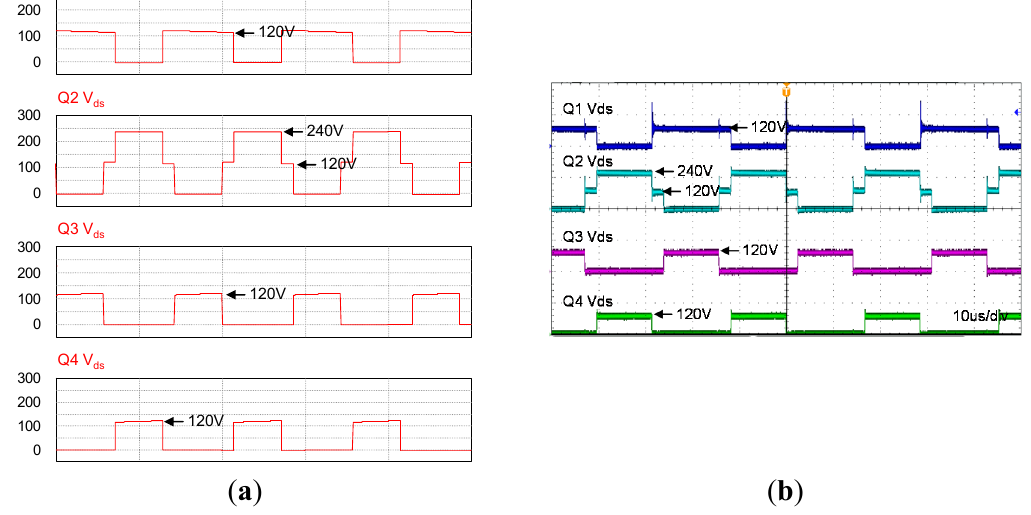
Figure 21. Waveforms of open-circuit voltage of switches Q 1 ~ Q 4 in the discharge mode at full load ( a ) by simulation; and ( b ) by measurement.